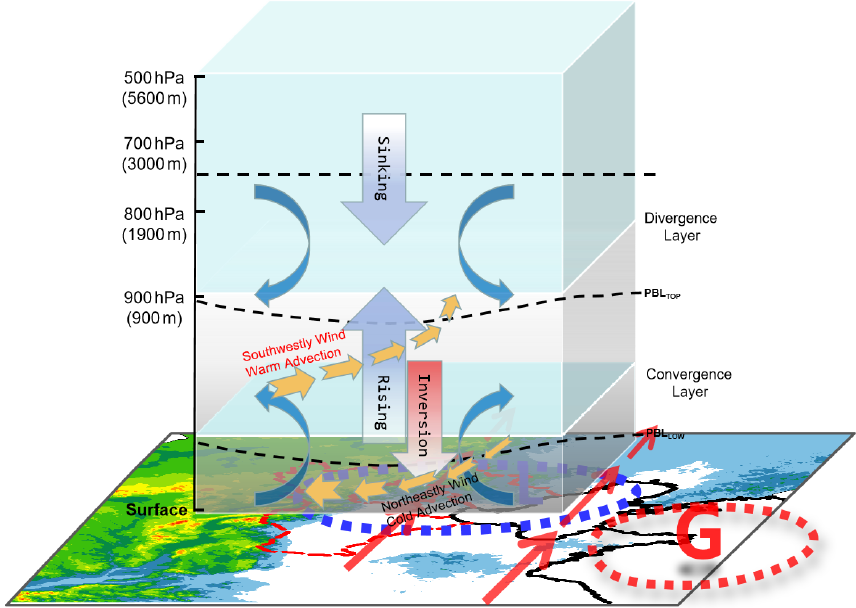
Figure 13. The schematic of the vertical-coupling mechanism of multiscale circulations for typical pollution types. The horizontal part is the background circulations of MSLP; the vertical part is the PBL thermodynamic structure over the NCP